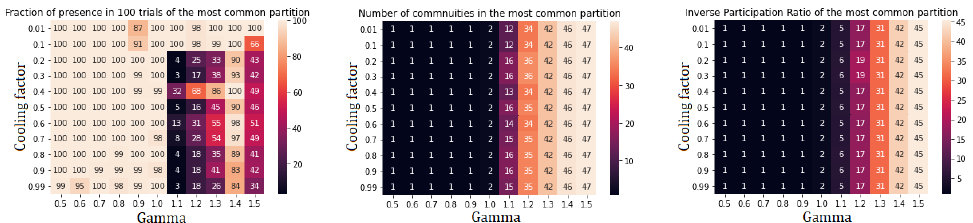
Figure A2. Performance indicators for Spin Glass algorithm applied to community 0. Two subcom- munities are found: community I (22 nodes) and community II (27